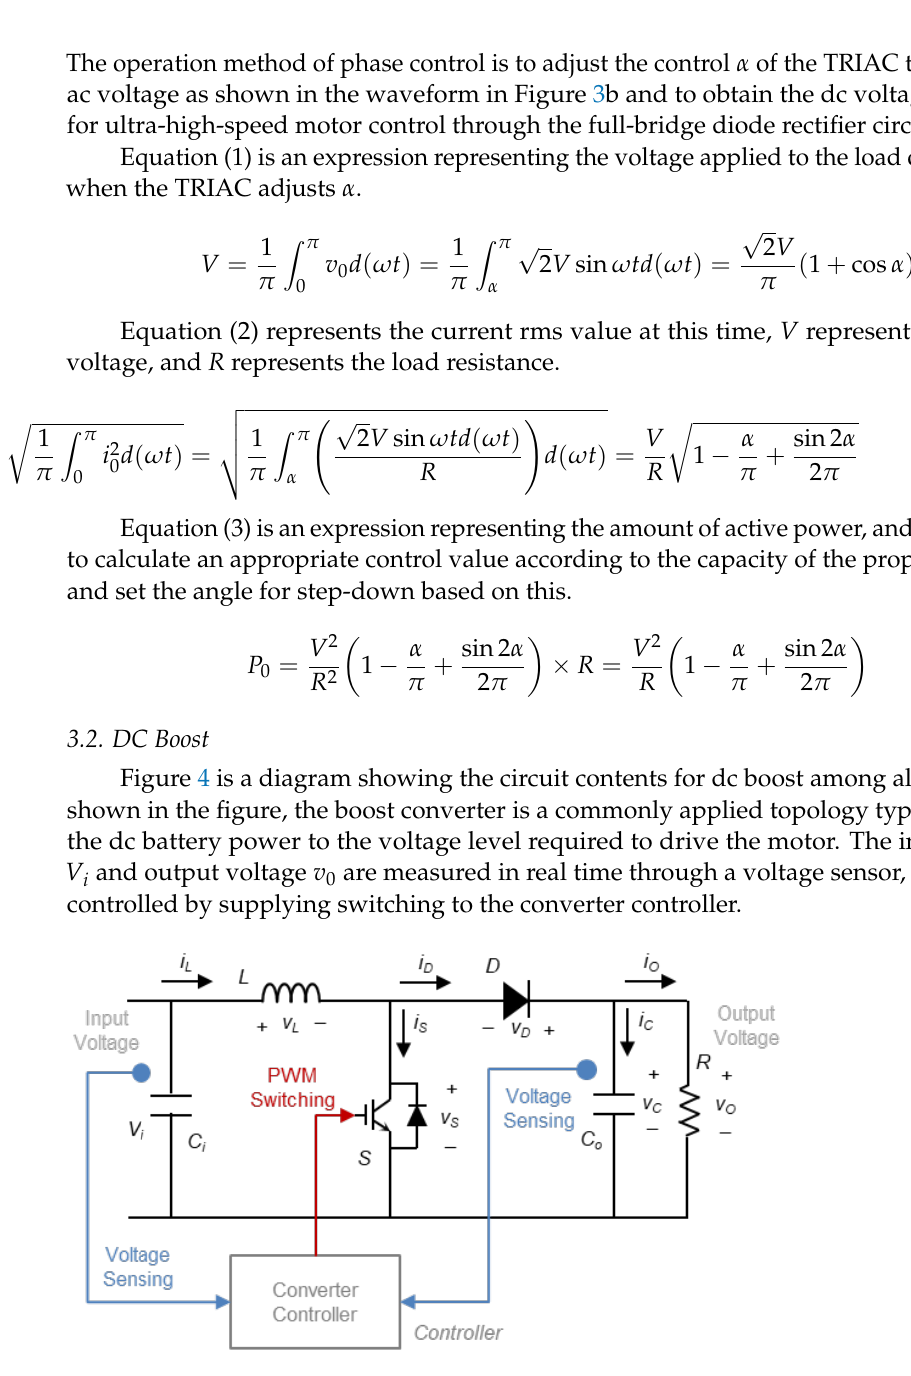
Figure 4. Concept diagram of DC boost converter circuit.